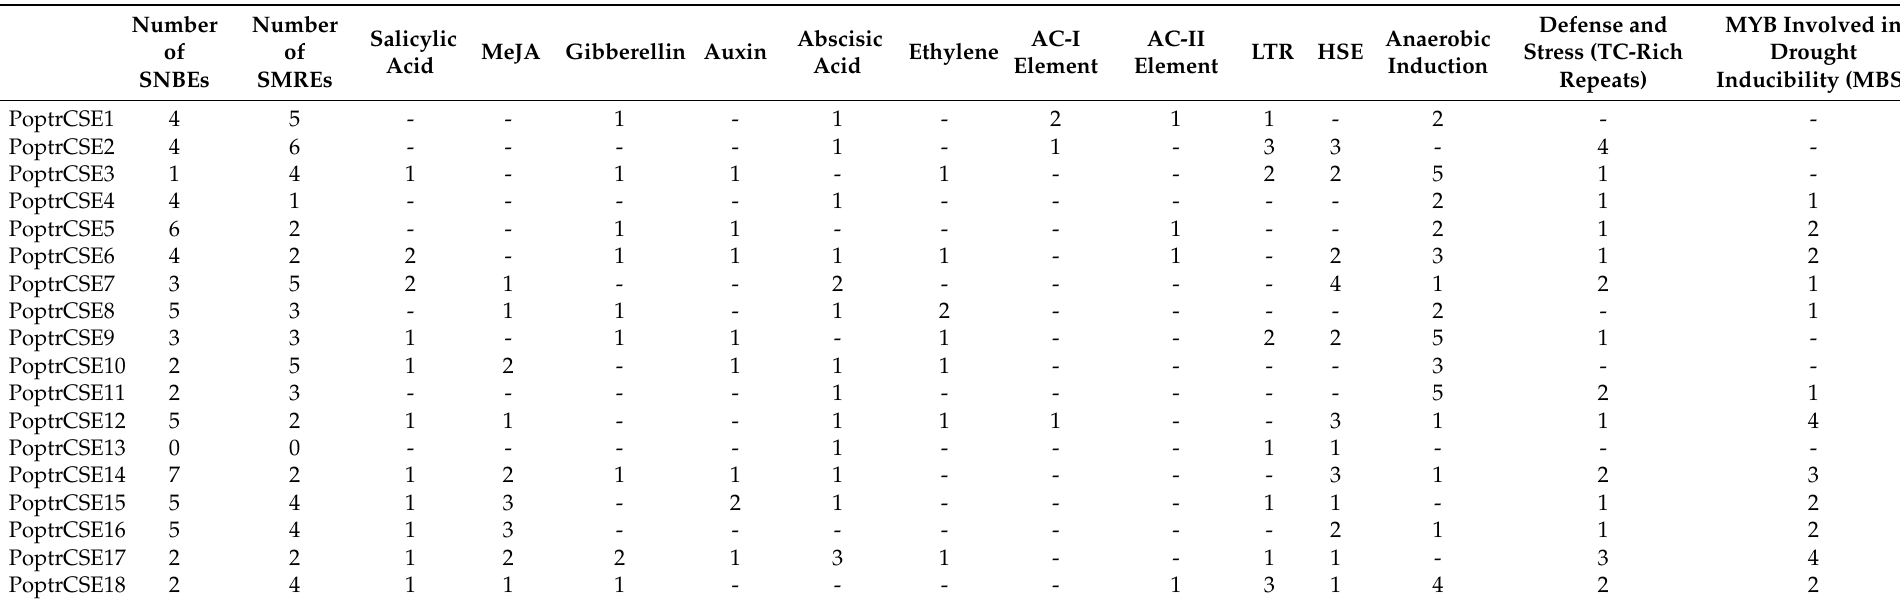
Table 1. List of motifs found in the promoter regions of PoptrCSE genes in Populus . PlantCARE (http://bioinformatics.psb.ugent.be/webtools/plantcare/html/) (access date: 30 October 2021) with a selected matrix score of ≥ 5 for all elements was adopted to obtain the putative motifs. The number of specific motifs in each gene is marked. More detailed information about all detected motifs is available in Supplementary Table S2. SNBE: secondary wall NAC binding element, SMRE: secondary wall MYB responsive element, LTR: low temperature responsive element, HSE: heat stress responsive